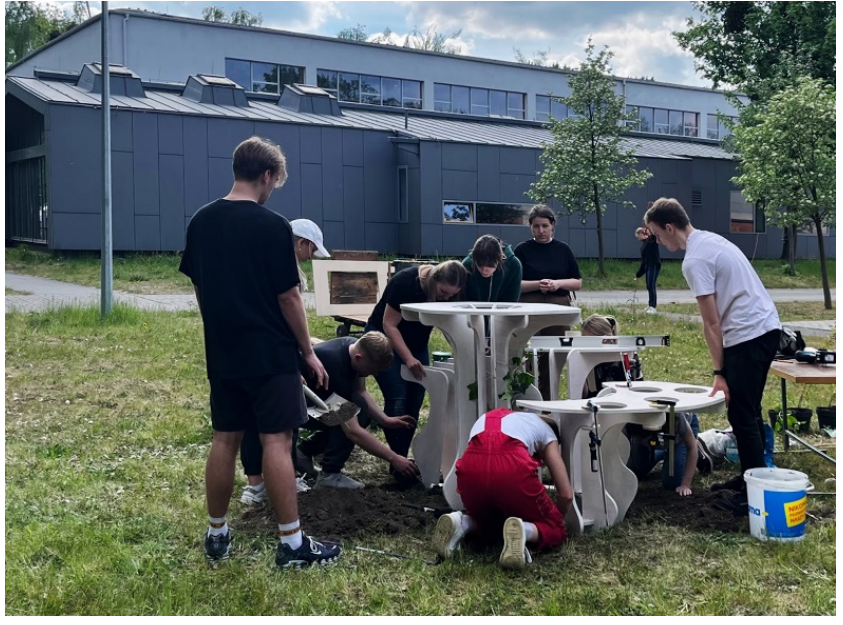
Figure 12. Assembly of the structure.